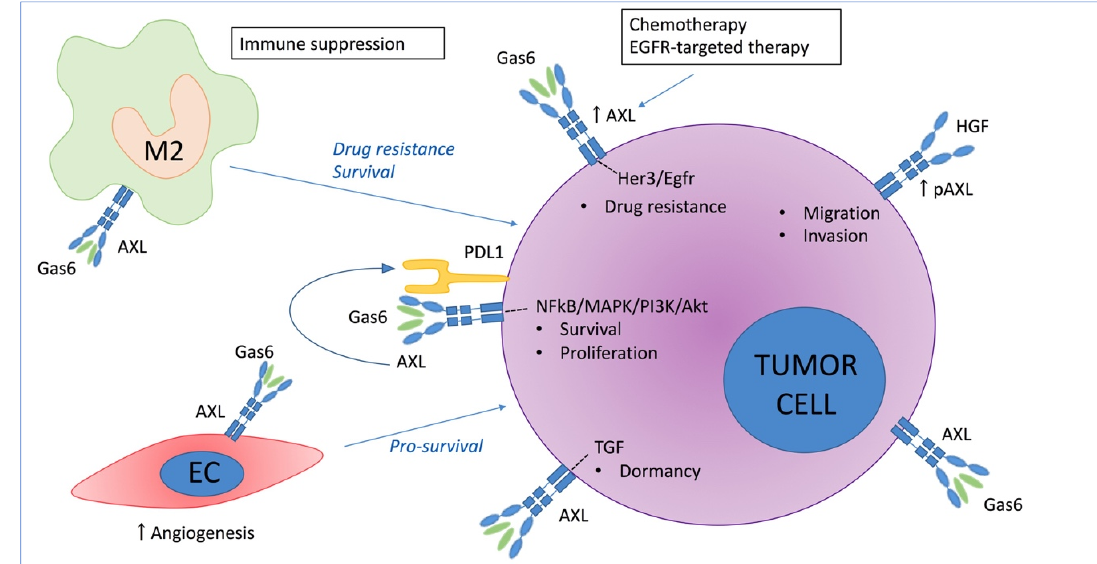
Figure 2. Schematic overview of the role of the GAS6/AXL axis in the tumor microenvironment focusing on tumor cell survival, proliferation, M2 polarization, migration, invasion, angiogenesis, dormancy, and drug resistance. EC = endothelial cells, M2 = type 2 macrophages. Her = human epidermal growth factor receptor, Egfr = epidermal growth factor receptor, HGF = hepatocyte growth factor, NFkB = nuclear factor kappa-light-chain-enhancer of activated B cells, MAPK = mitogen-activated protein kinases, Akt = protein kinase B, TGF = transforming growth factor, PDL1 = programmed death-ligand 1